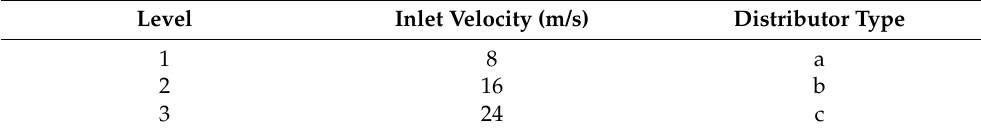
Table 1. The schedule of air distributor CFD